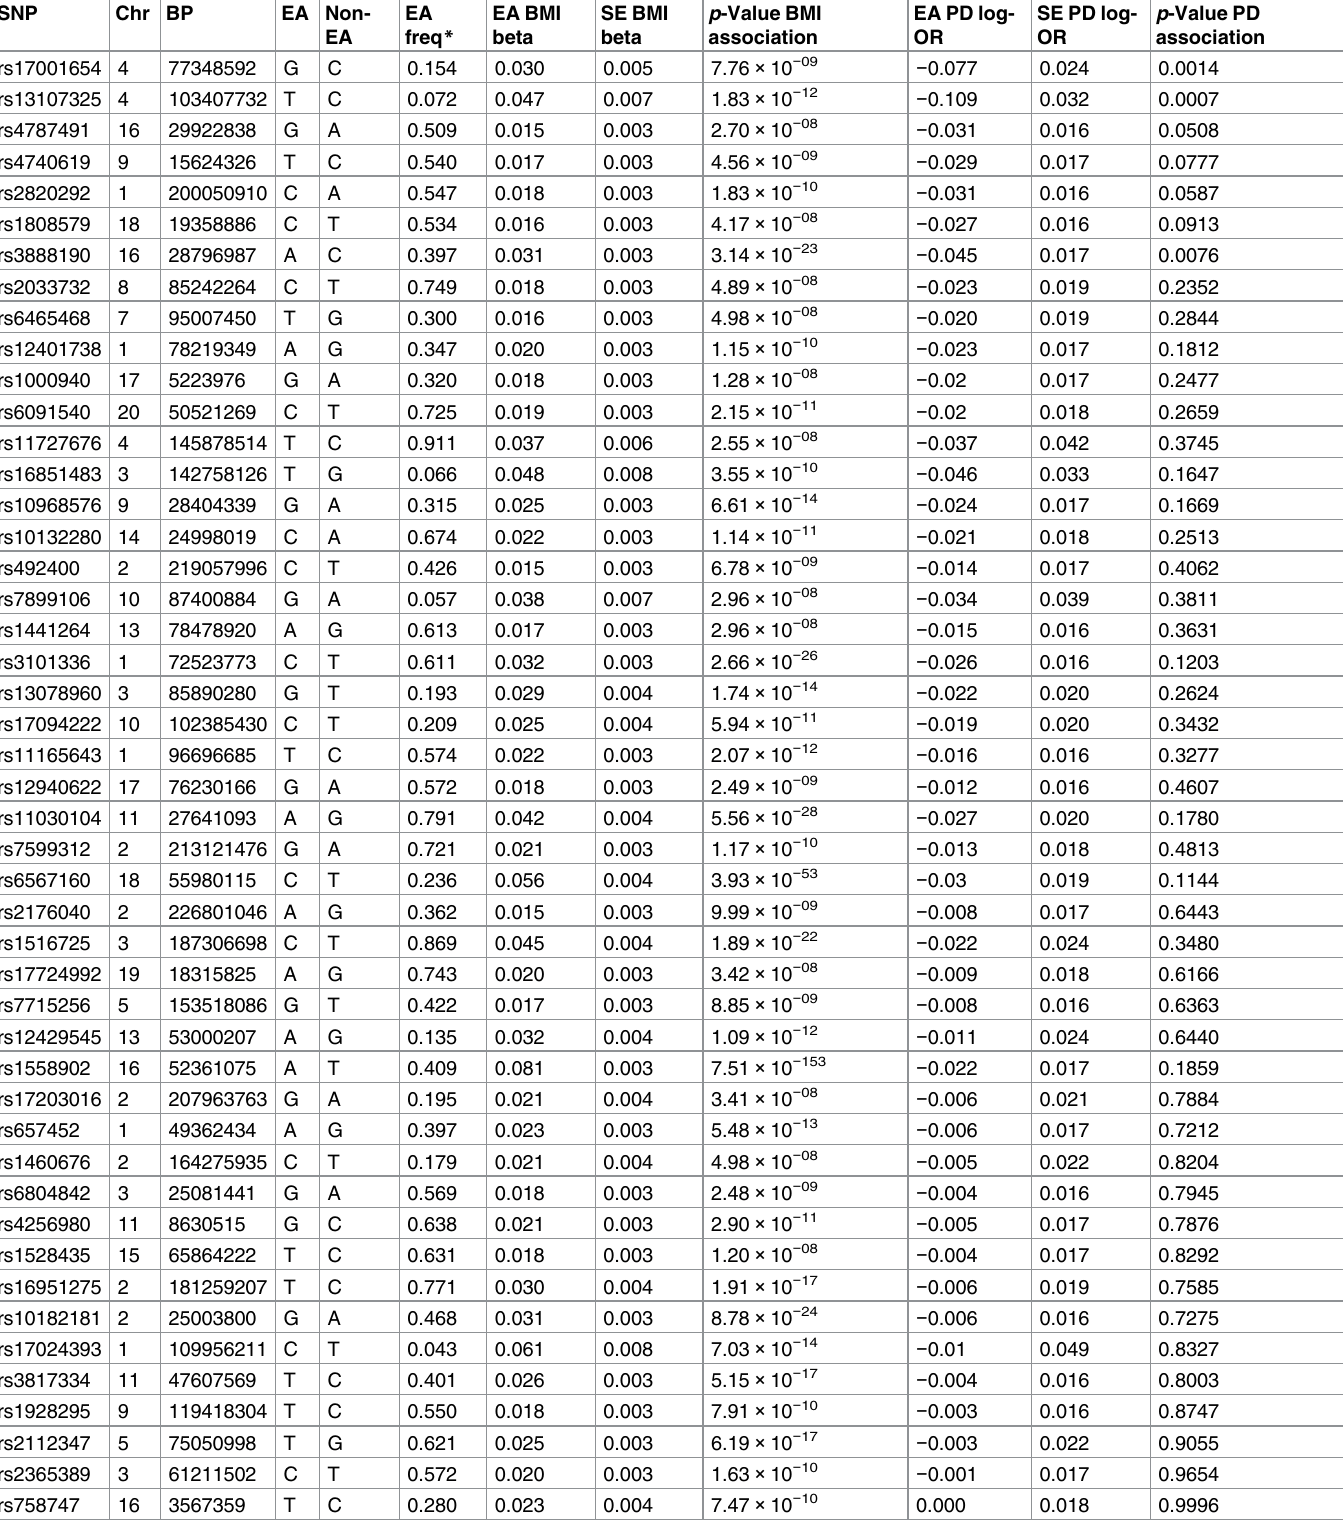
Table 1. Variants and effect alleles with frequencies and magnitude of effect on BMI and strength of association with